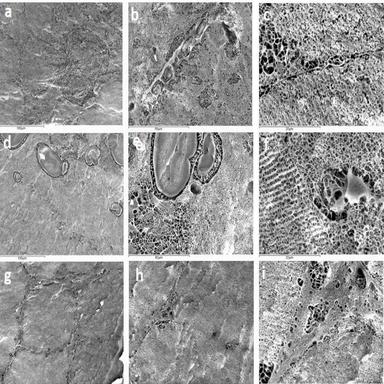
Fresh processed meat products observed by Cryo-SEM at different magnifications. Pork ham (a, b and c), turkey ham (d, e and f) and bacon (g, h and).